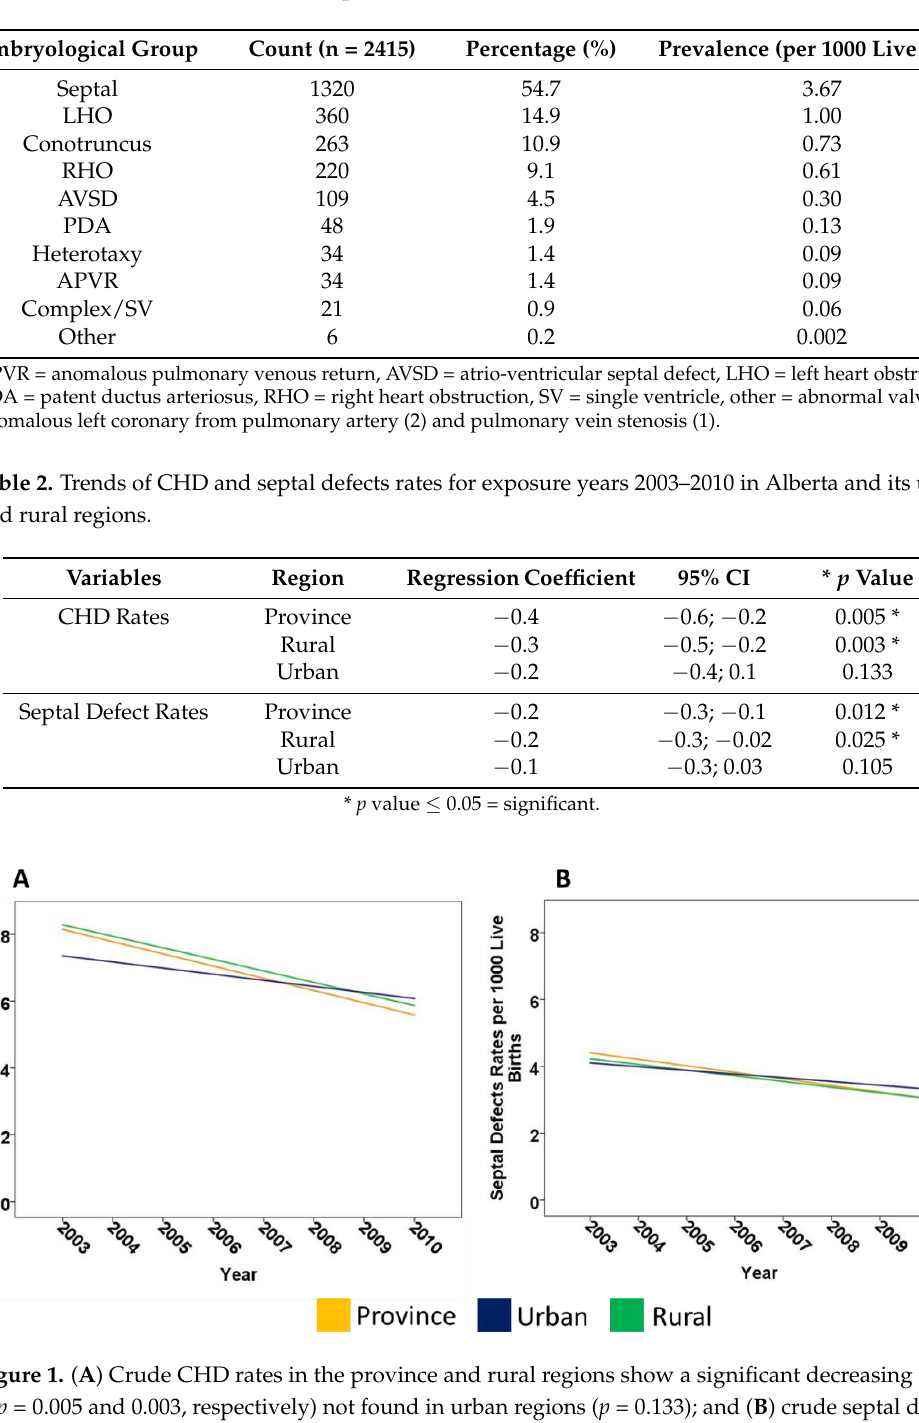
Table 1. Proportions of CHD in Alberta 2004–2011.